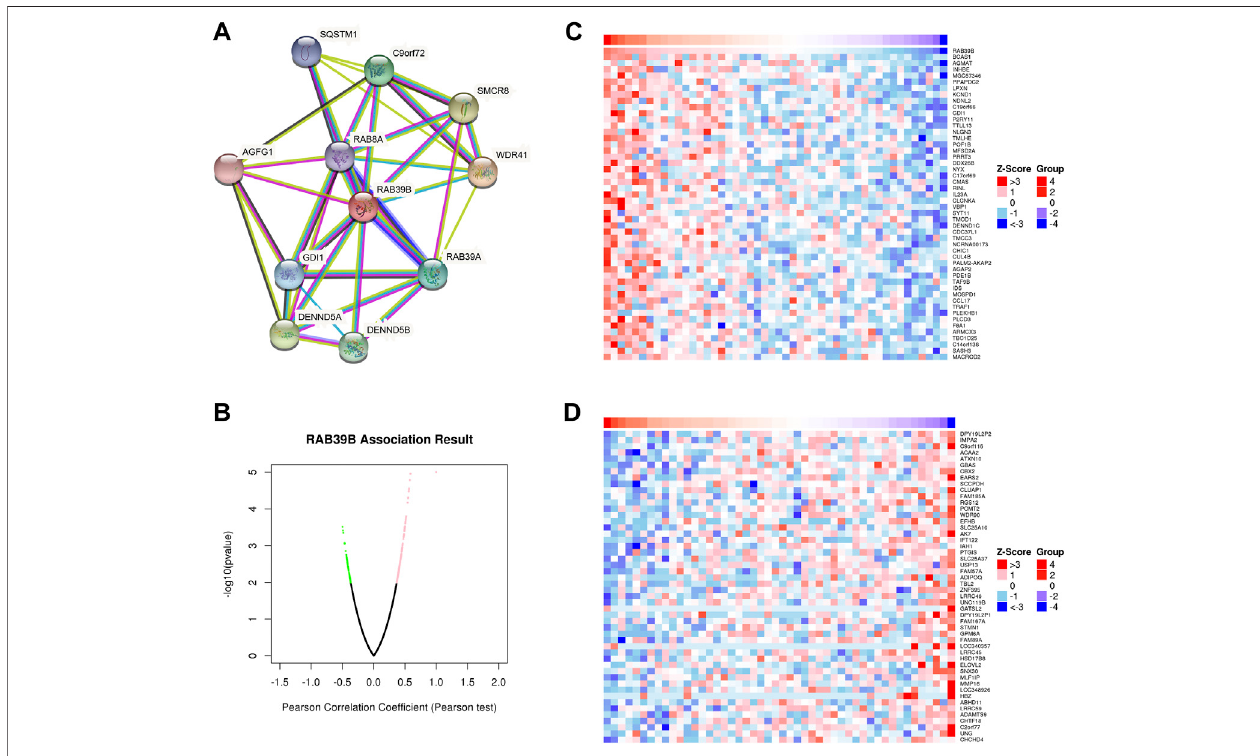
FIGURE2 | RAB39BPPI network and co-expression genes in DLBCL. (A) PPInetworkof RAB39B. (B) Genes highly correlated withRAB39Bidenti fi ed in DLBCL by the Pearson test in the LinkedOmics database. (C) Top 50 genes positively related to RAB39B in DLBCL. (D) Top 50 genes negatively correlated with RAB39B in